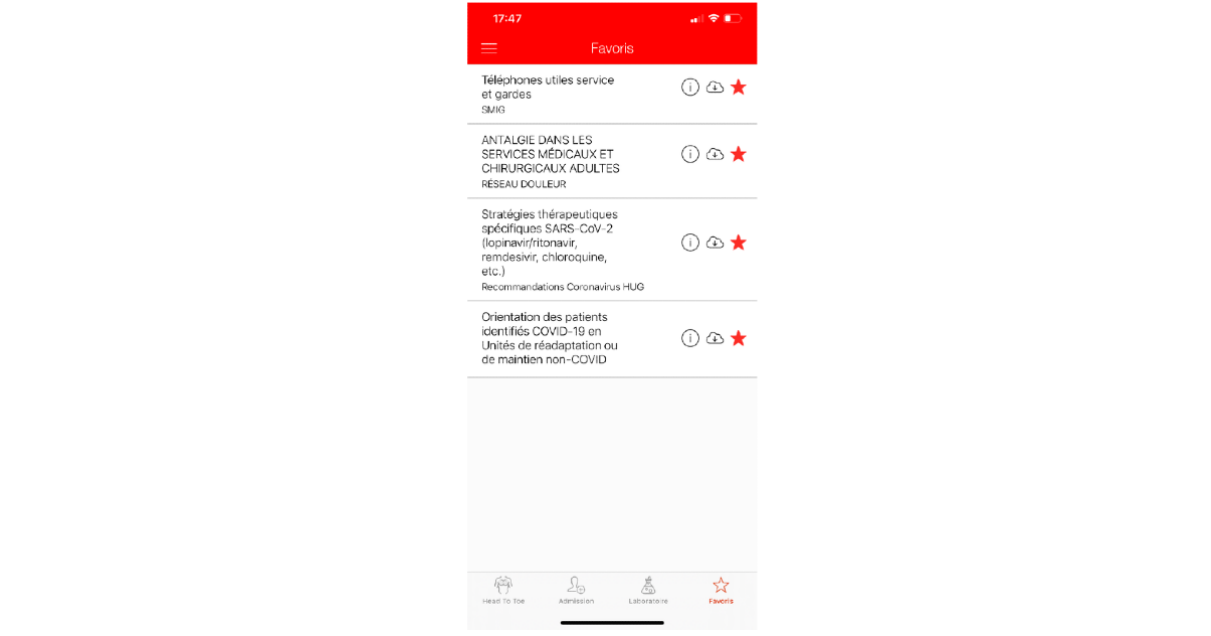
Figure 5. Favorites screen in the HeadToToe platform (in French). Through this screen, users can quickly access marked content.